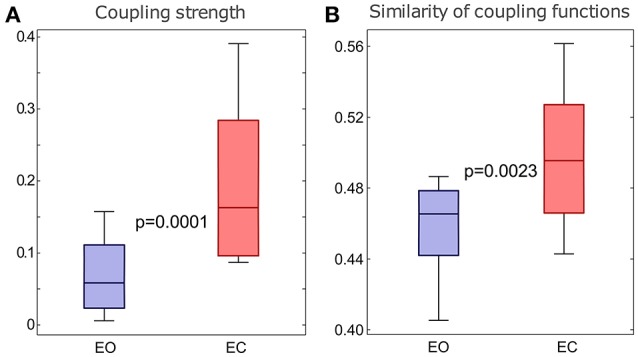
Differences in the δ-to-α coupling strength above surrogates (A) and in the similarity of form of the δ-to-α coupling functions (B) for the two groups of subjects with EO and EC. The p-values indicated within each panel represent the statistical differences between the EO and EC states. Whiskers indicate ±2.7 standard deviations of the distribution.